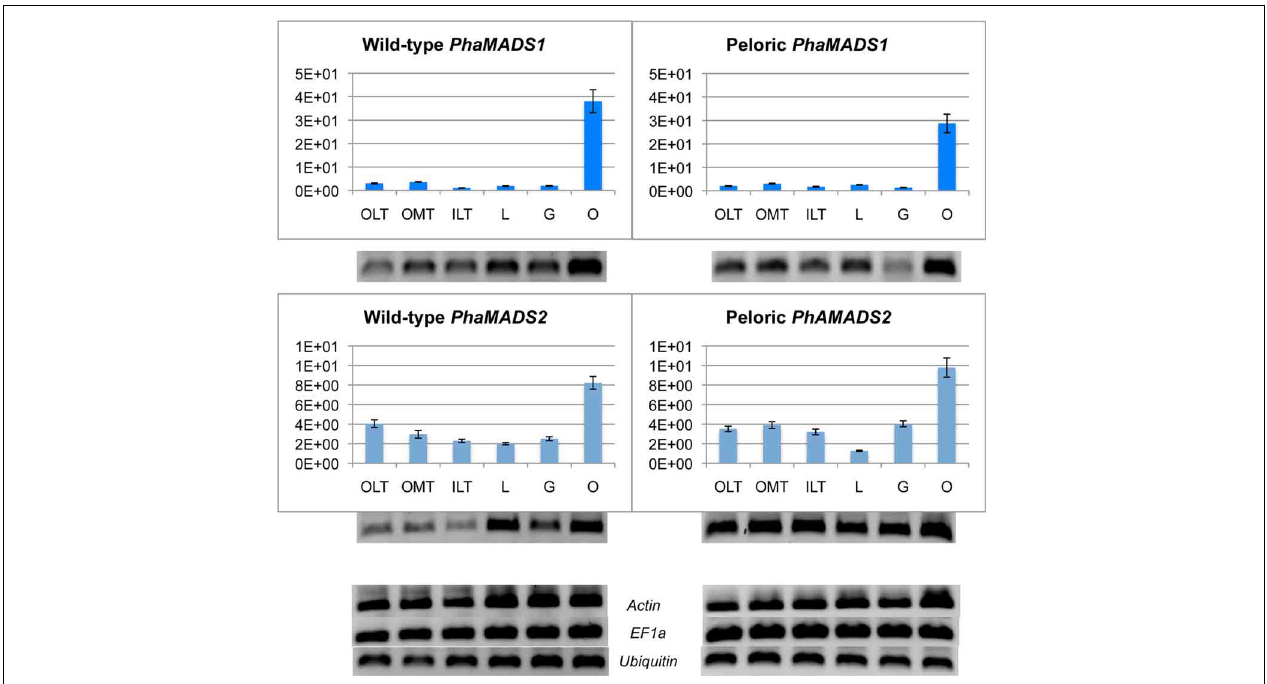
FIGURE 5 | Normalized expression of orchid FUL -like genes. Expression of PhaMADS1 and PhaMADS2 in six flower organs of wild-type and peloric of Phalaenopsis hybrid “Athens.” OLT, outer lateral tepals; OMT, outer median tepals; ILT, inner lateral tepals; L, labellum; G, gynostemium; O, ovary. Expression of the target genes was normalized to the geometric average expression of three internal control